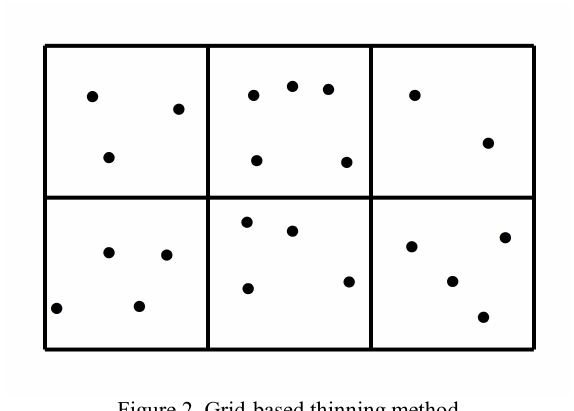
Figure 2. Grid-based thinning